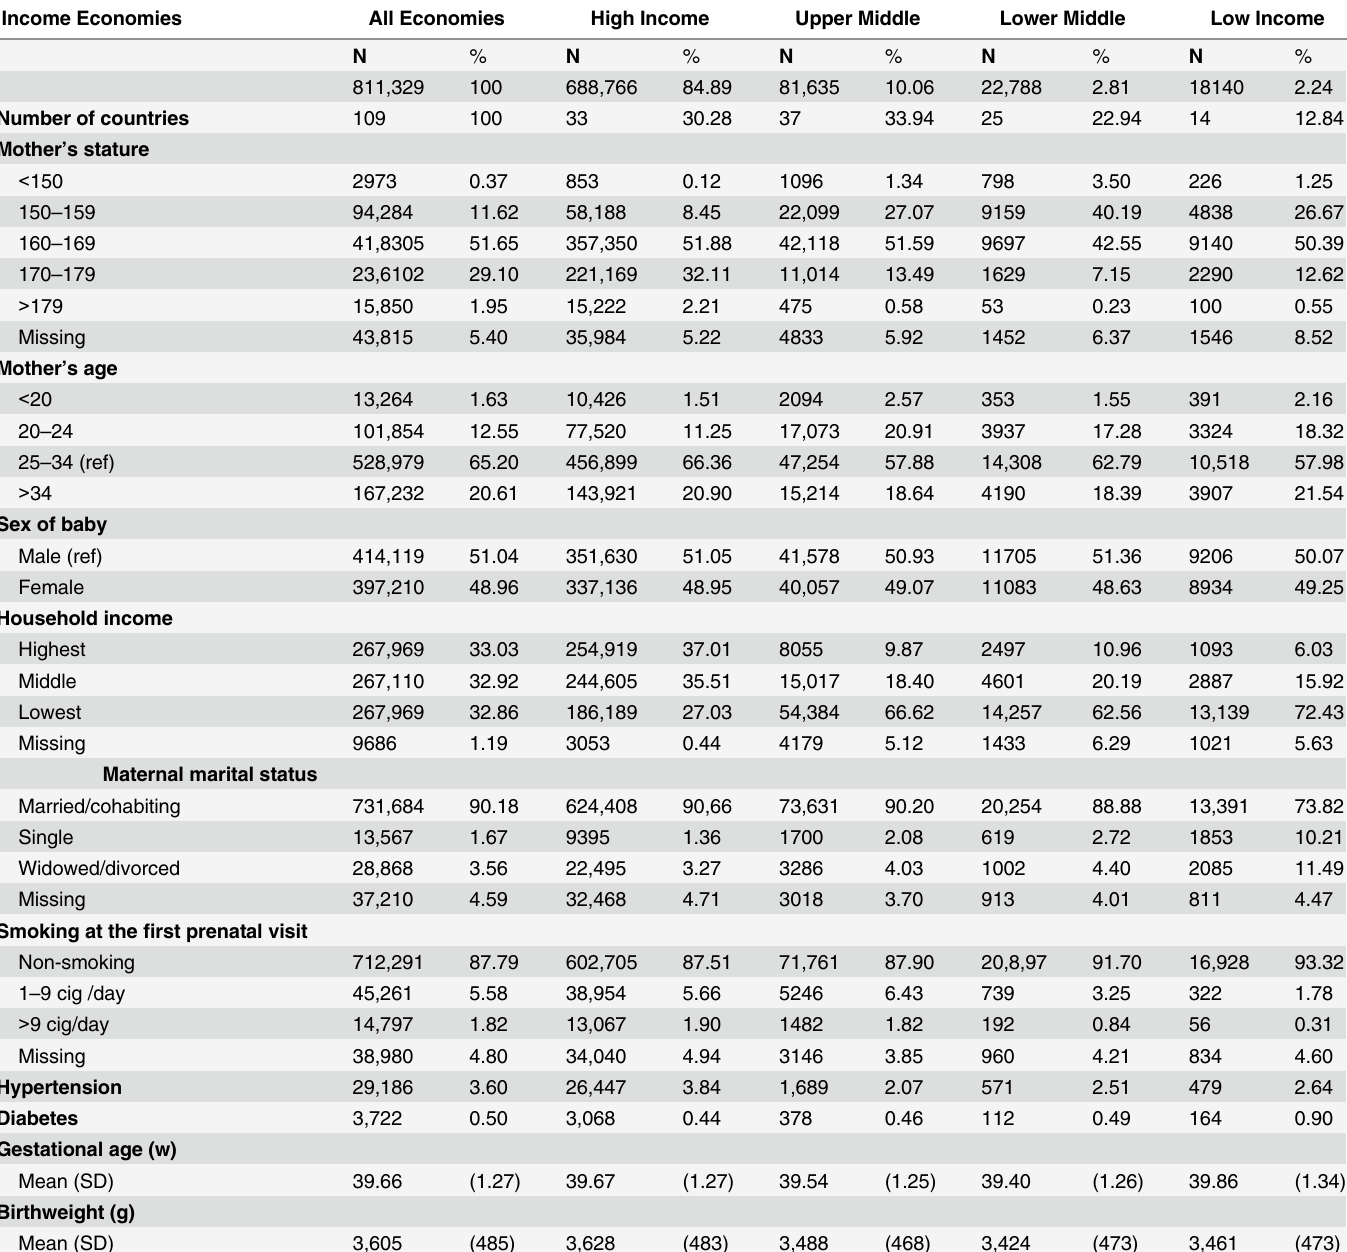
Table 1. Characteristics of the population by maternal country of birth economies according to the World Bank classification based on estimates of gross national income (GNI) per